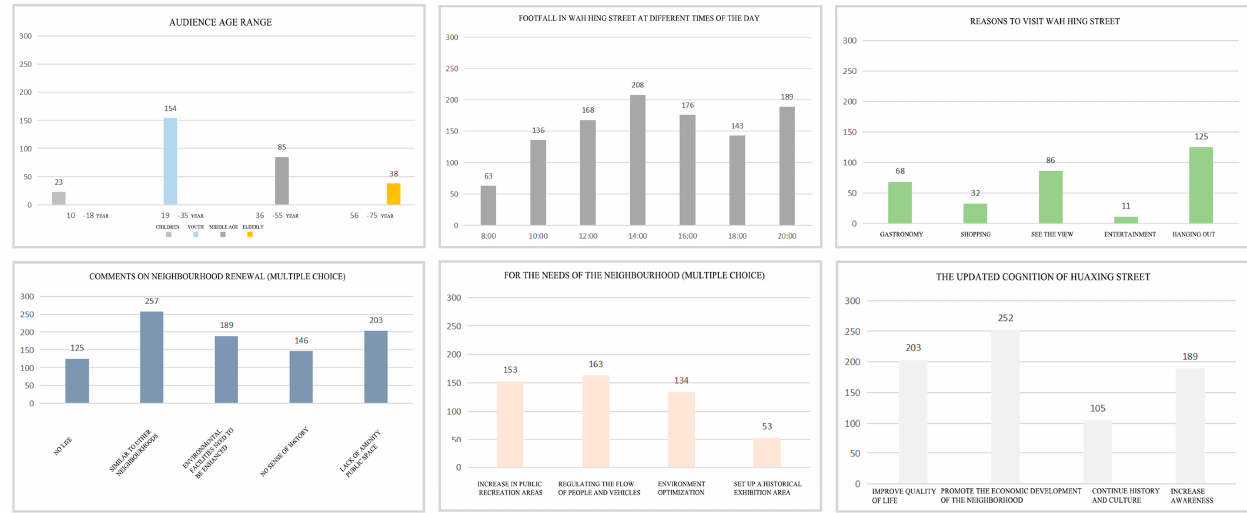
Figure 8. Finished Investigation and Analysis